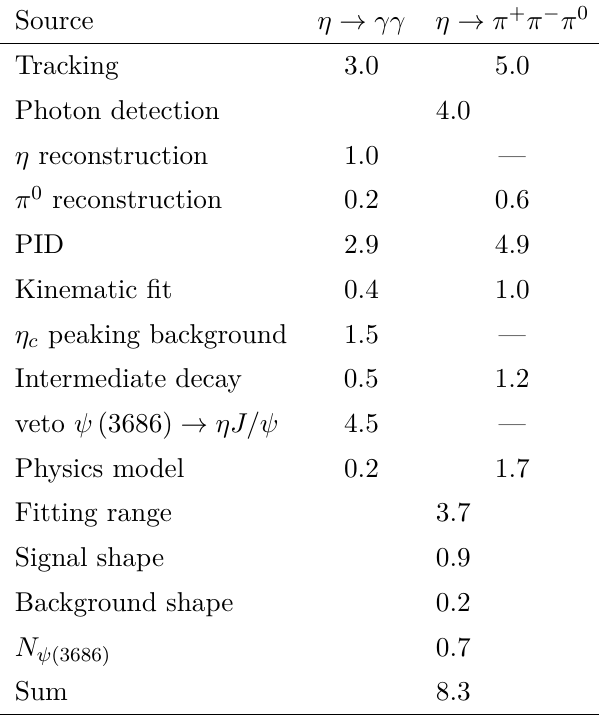
Table 5 . The relative systematic uncertainties for the h c → p ¯ pη channel (in % ). A dash indicates that the systematic uncertainty is not